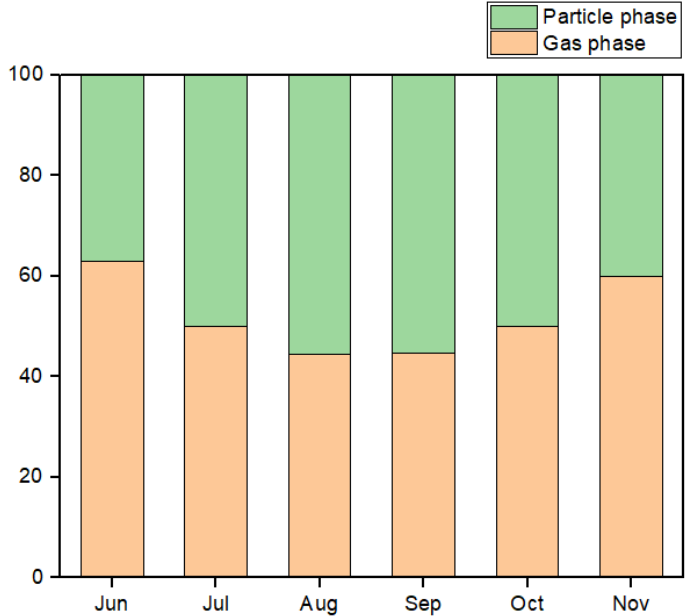
Figure 2. Gas and particulate fractions of PFHxS from June to November 2021.